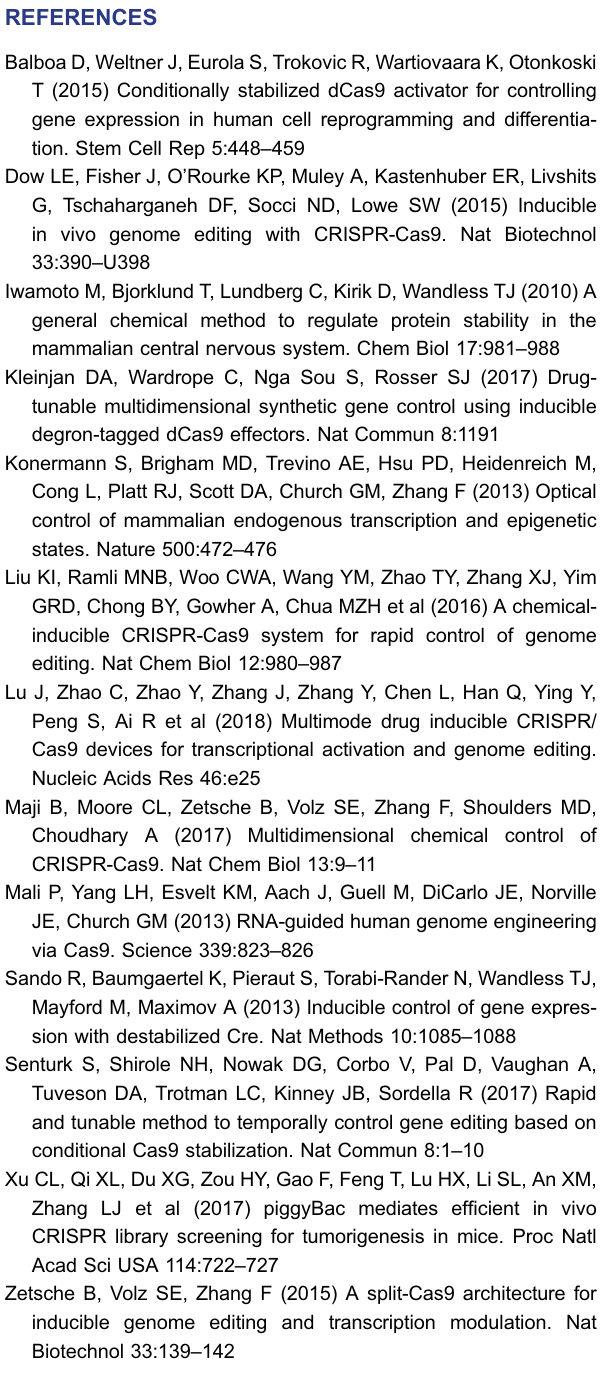
Figure 2. DD-Cas9 mediated liver tumorigenesis in an inducible manner . (A) Work fl ow of the induction of liver tumors in mice by hydrodynamic tail vein injection. (B) Representative liver tumors obtained from the mice under different treatments. Mice injected F5D and induced with TMP developed tumors with GFP fl uorescence. White arrows indicate tumor sites. Scale bar, 100 μ m. (C) T7EI cleavage assay of genome modi fi cation in a representative liver tumor. Red asterisks indicate the expected T7EI-speci fi c cleavage bands used to quantify indel frequencies (the bottom line). Tu, tumor sample. (D) Sequences of indel mutation in a representative liver tumor. Protospacer-adjacent motif (PAM) sequences were labeled in red and sgRNA coding sequences were labeled in cyan. (E) H & E and immunohistochemistry analysis of the indicated liver samples. Slides showed that tumor cells grew in a tubular pattern and proliferated rapidly by highly expressing Ki67 in contrast to the other liver tissues. Scale bar, 100 μ